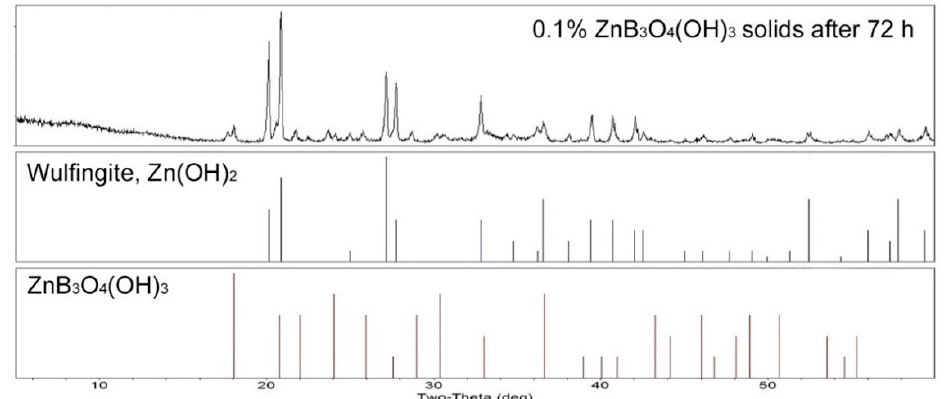
Figure 5. PXRD pattern of the solids resulting from hydrolysis of a 0.10% slurry of zinc borate ZnB 3 O 4 (OH) 3 ( top ), reference peaks for wulfingite, Zn(OH) 2 ( middle ) and zinc borate, ZnB 3 O 4 (OH) 3 ( bottom ).